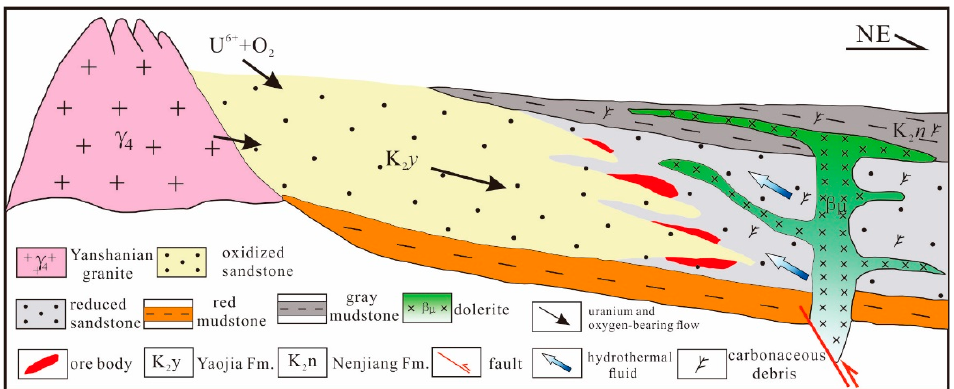
Figure 10. Generalized model showing the relationship between dolerite intrusion and uranium mineralization in Qianjiadian ore field.